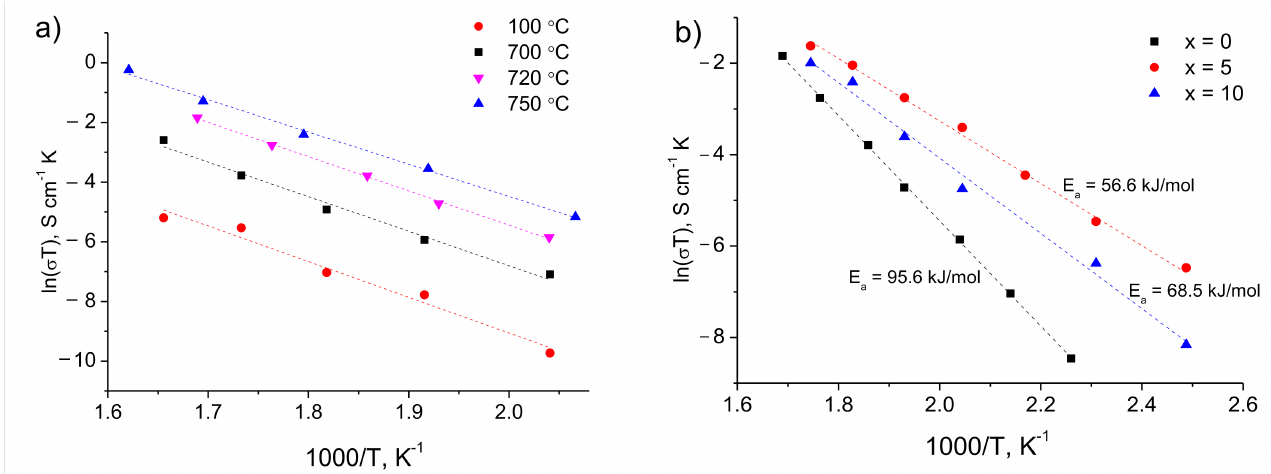
Figure 11. Arrhenius plots for the total conductivity of half-cells: ( a ) Li 4 Ti 5 O 12 |c-LLZ after heat treatment at different temperatures (100, 700, 720 and 750 ◦ C); ( b ) (100 − x )Li 4 Ti 5 O 12 + x Li 3 BO 3 |c-LLZ, annealed at 720 ◦